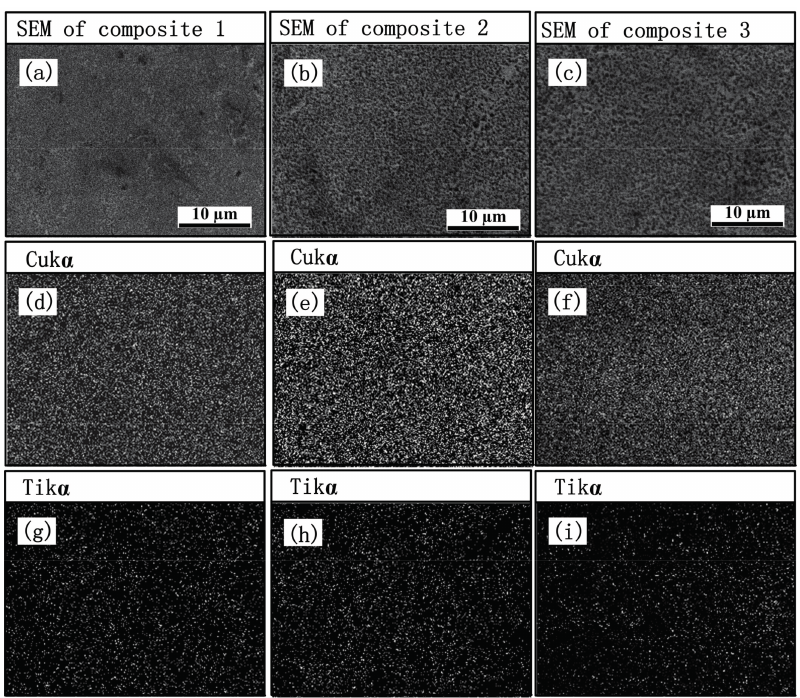
Figure 2. ( a – c ) SEM images and ( d – i ) energy dispersive spectrometry (EDS) of etched surfaces of composites 1, 2, and